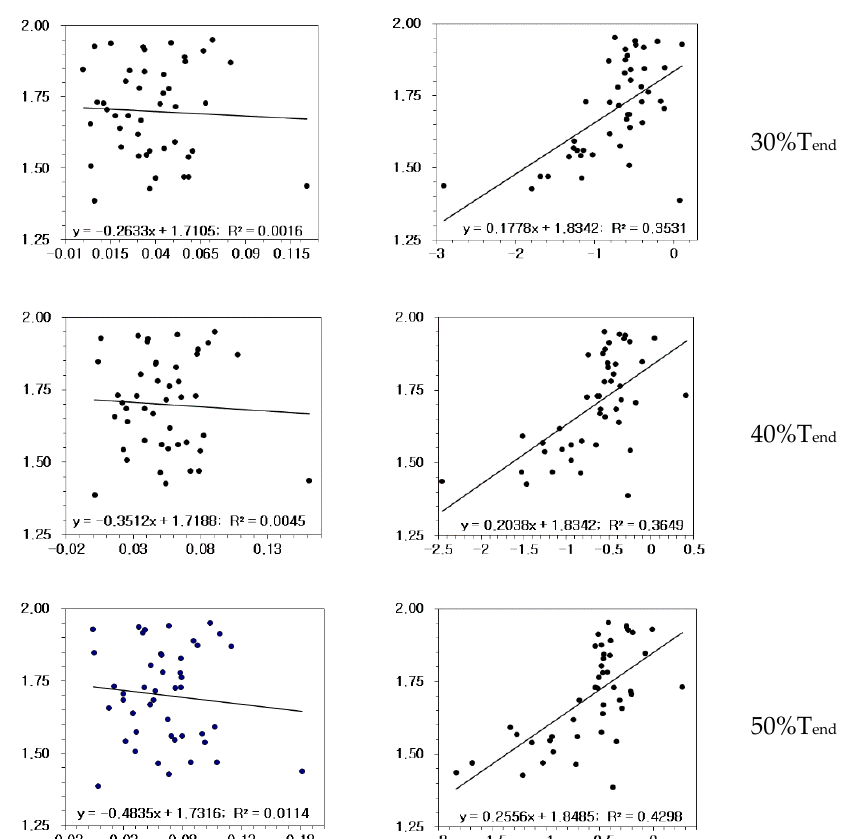
Figure 12. Scatter plots of the area ratio in the column ( a ) and the slope in the column ( b ) of logH/L-SM against log (T end ).